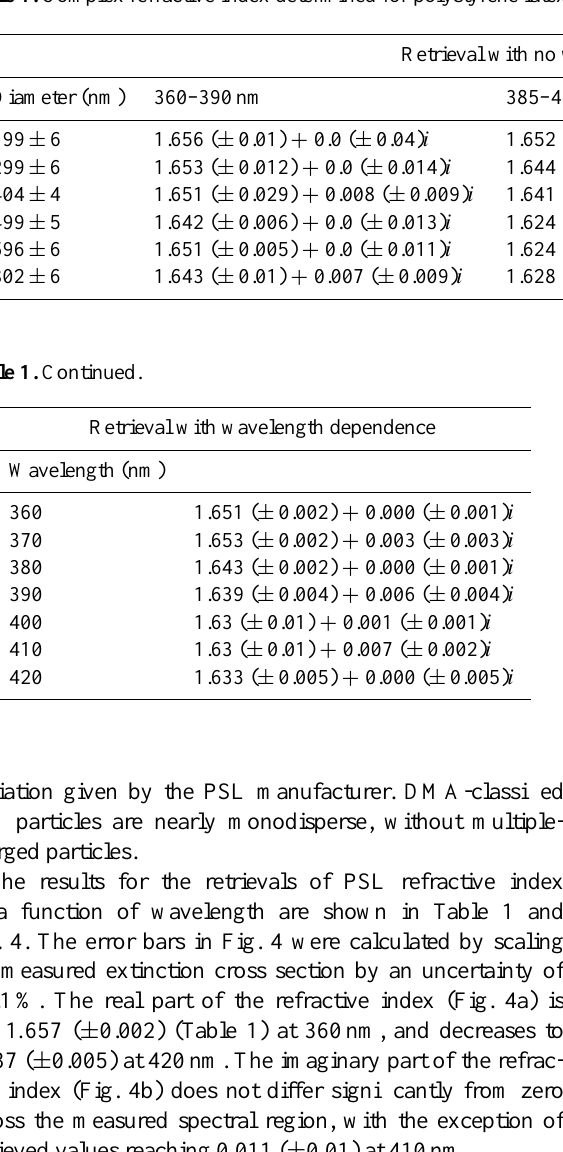
Table 1. Complex refractive index determined for polystyrene latex spheres using two methods.